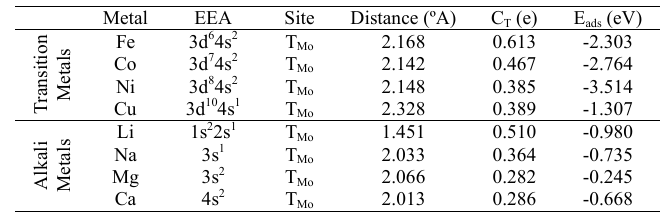
Table 2. Calculated extra nuclear electrons arrangement (EEA), adsorption energies (E transfer (C ) of the metal atoms adsorbed on mMoS T